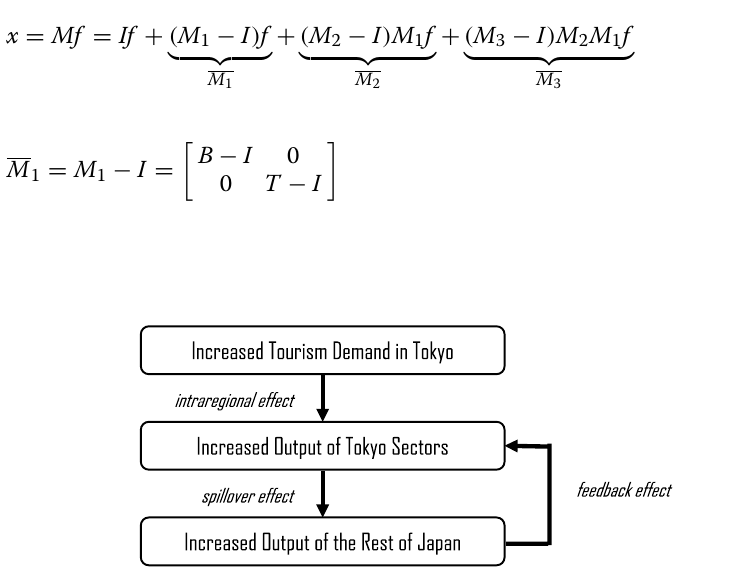
Fig. 2 Mechanism of tourism-led effects transmission. Source: Adapted from Miller and Blair